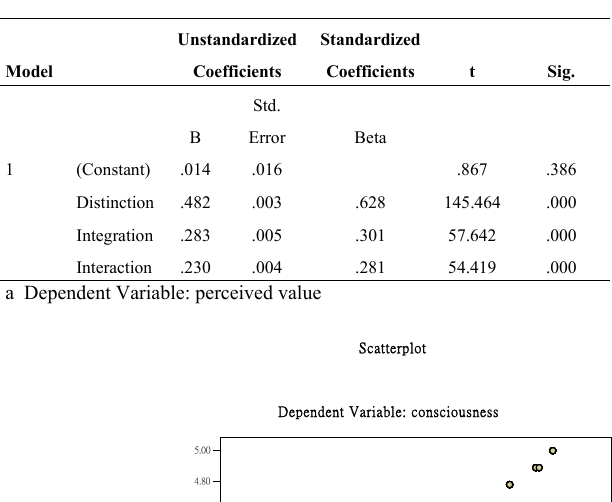
Table 12: The model summary of the linear regression